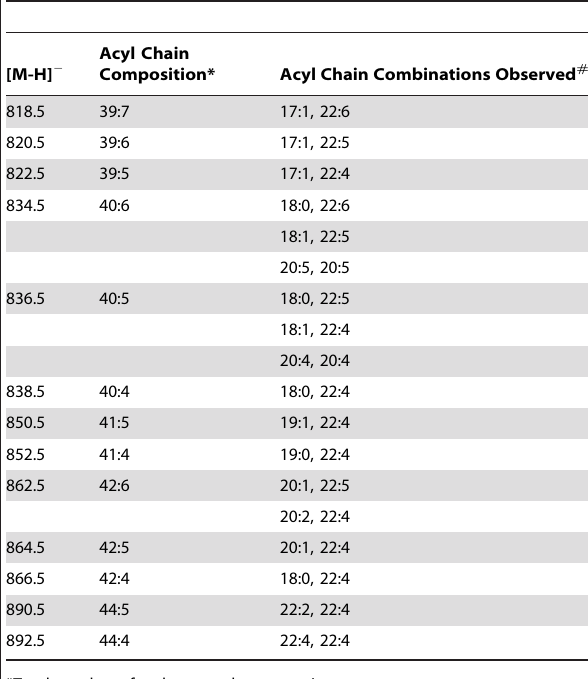
Table 2. Phosphatidylserine species identified in A. pallida lipid